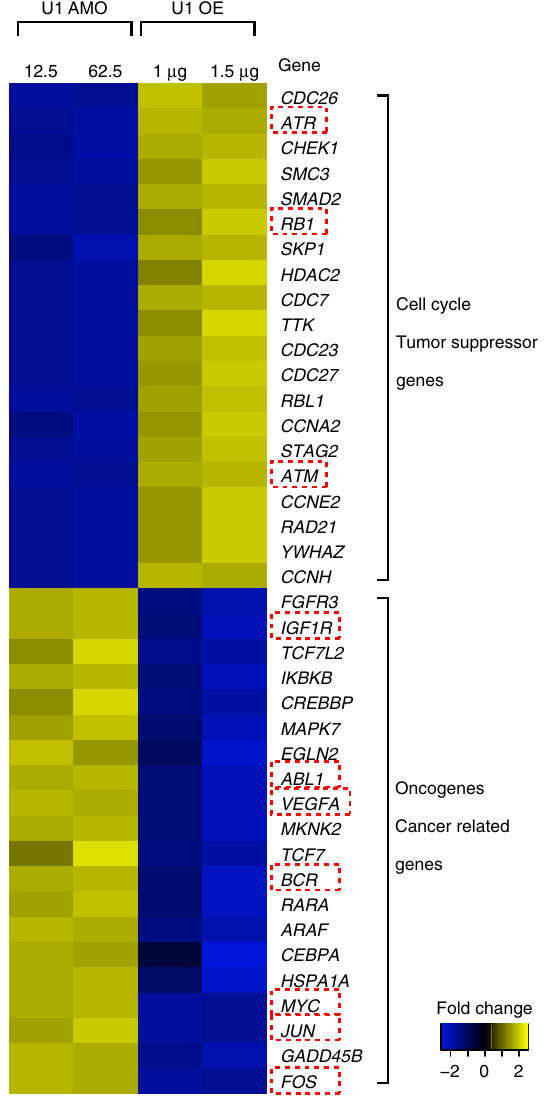
Fig. 5 U1 AMO upregulated oncogenes and downregulates tumor suppressor genes and U1 over-expression antagonizes the effect in HeLa cells. Heat map showing genes related to cell cycle and tumor suppressor function are downregulated in U1 AMO and upregulated in U1 OE. Oncogene and cancer related genes are upregulated in U1 AMO and downregulated in U1 OE (1.5-fold change, P -value < 0.01 calculated by GFold 55 ). Source data are provided as a Source Data fi